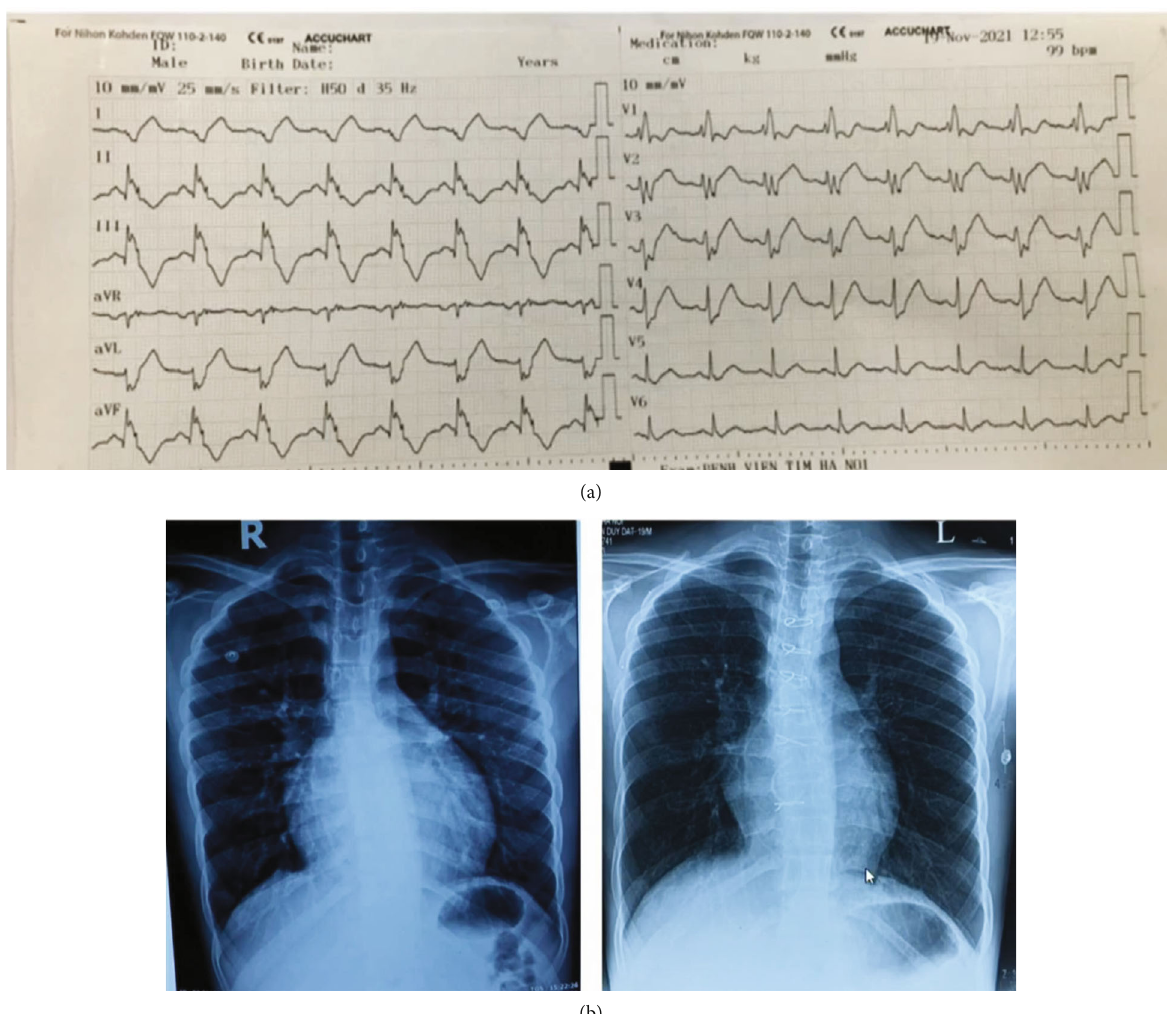
Figure 4: (a) ECG after ablating shows sinus rhythm of 99bpm and right bundle branch block. (b) Thoracic X-ray shows smaller cardiac- pulmonary